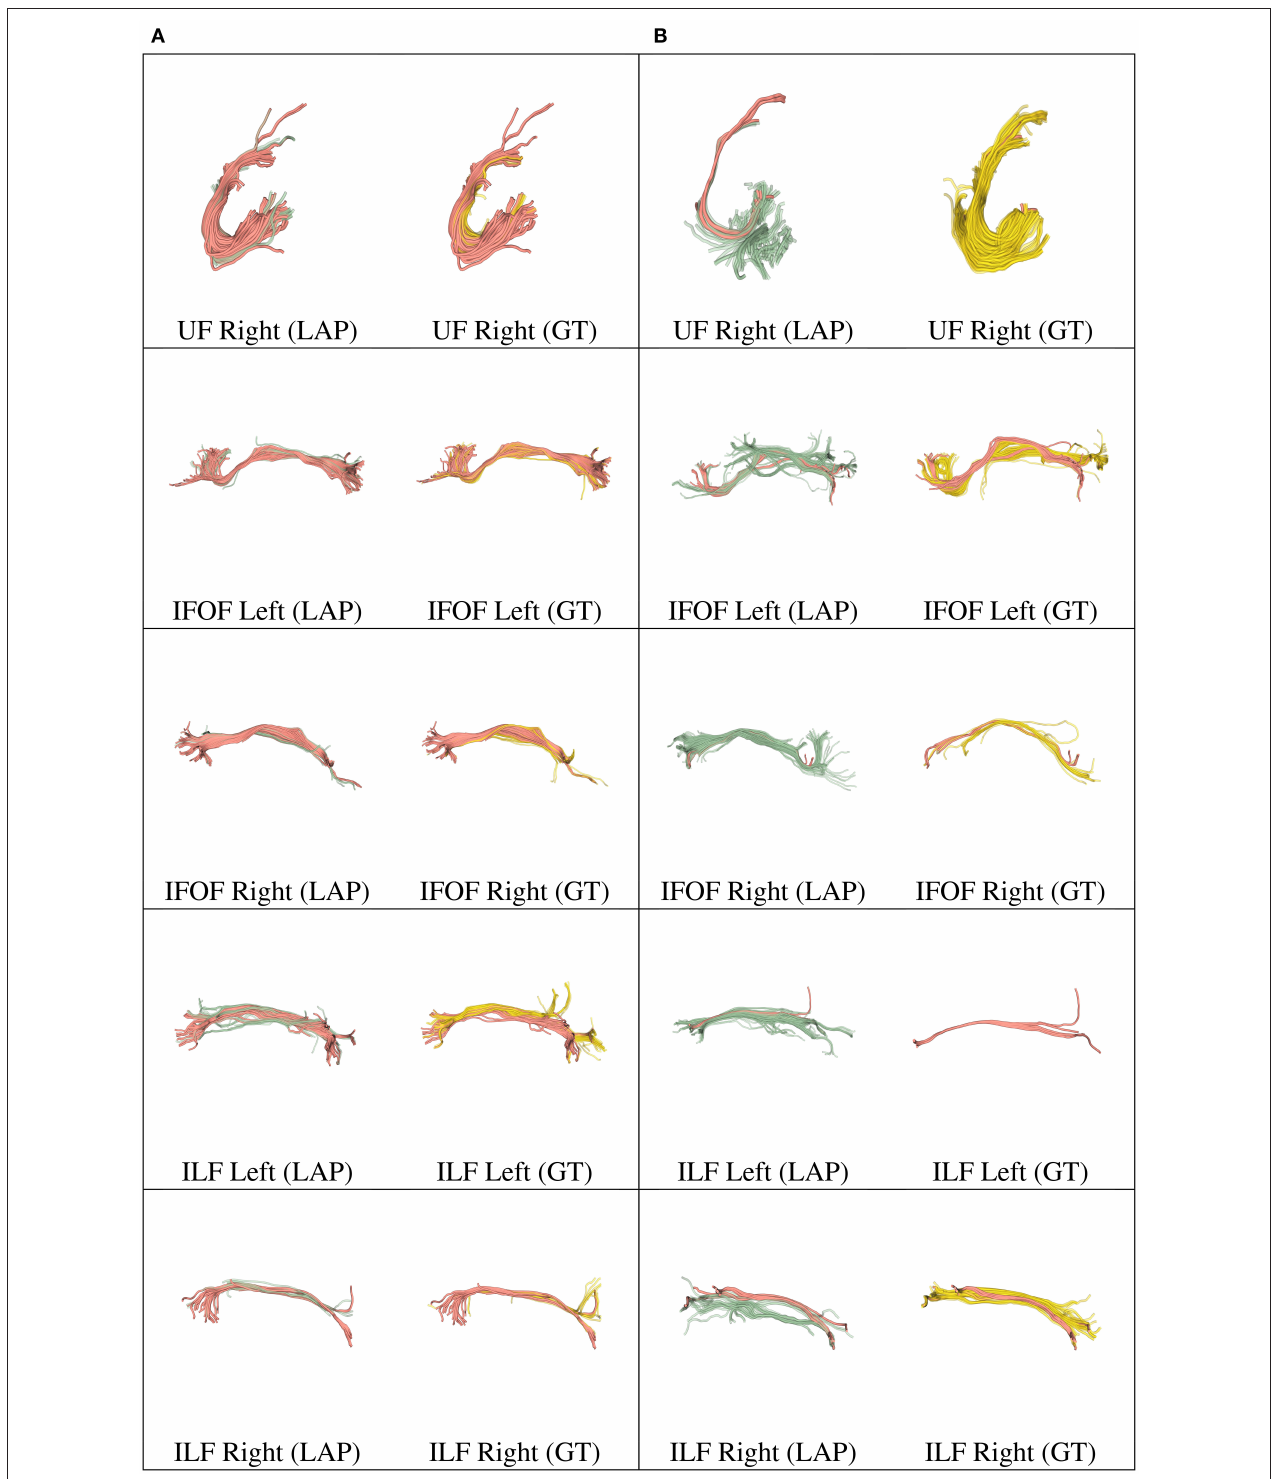
FIGURE 6 | In each row, in column (A) , we show the tract obtained with LAP-based segmentation (LAP) with highest DSC score among all test subjects, together with the related ground truth (GT). In column (B) , we show the one with lowest DSC score, together with the ground truth. The streamline of salmon color are TP, the ones in green are FP and the ones in yellow are FN. The tracts are: and UF (right), IFOF (left, right) and ILF (left, right).